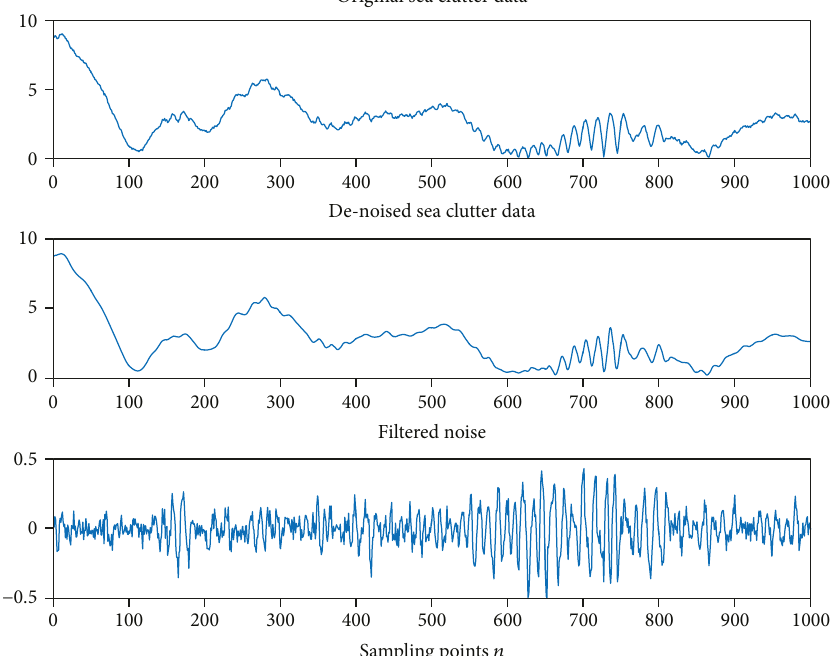
Figure 7: De-noising results of sea clutter based on the joint algorithm combined CEEMD with wavelet transform.